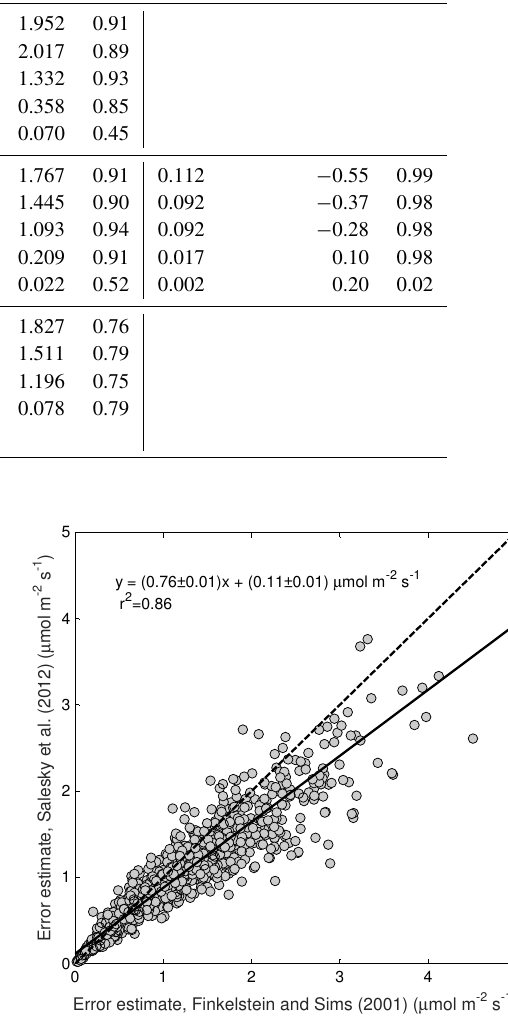
Figure 3. Error estimate calculated based on the Salesky et al. (2012) method ( ˆ δ F,S , Eq. (10) in this study) plotted against the error estimated according to the Finkelstein and Sims (2001) method ( ˆ δ F,FS , Eq. (6) in this study) for forest